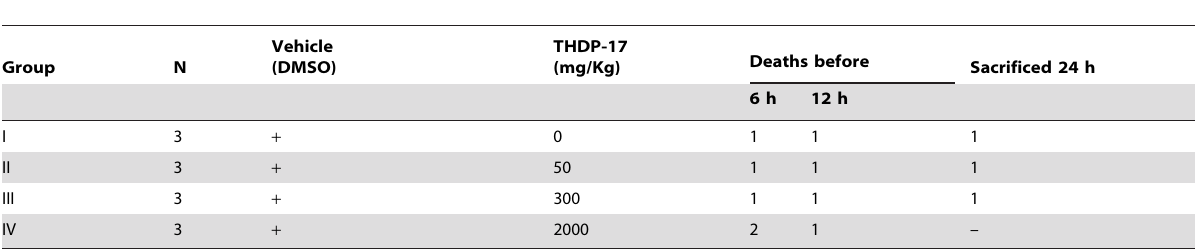
Animals were divided in 4 groups and deaths after treatment were recorded.